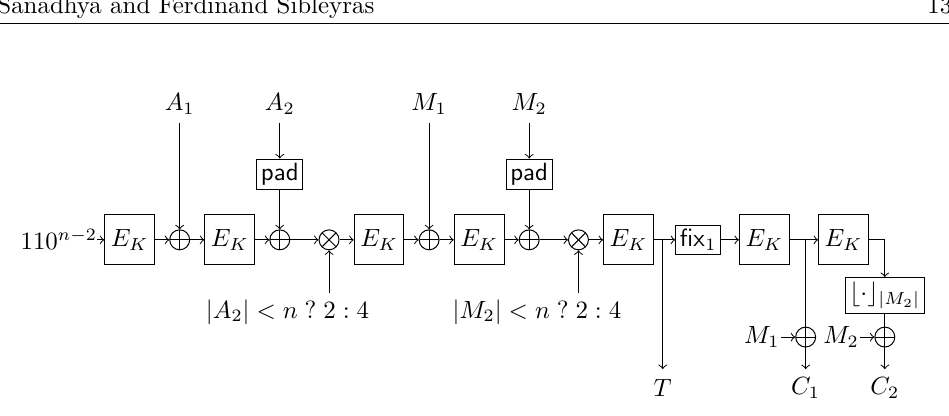
Figure 5: The authenticated encryption scheme MONDAE (Section 5.3), for 0 < | A | ≤ 2 n and 0 < | M | ≤ 2 n .